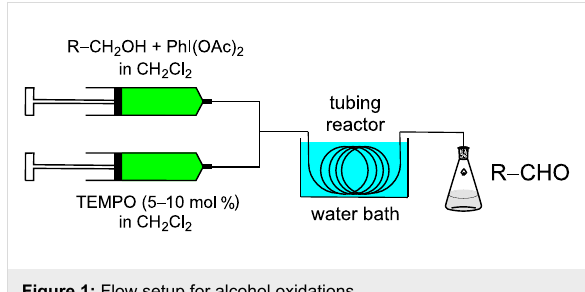
Figure 1: Flow setup for alcohol